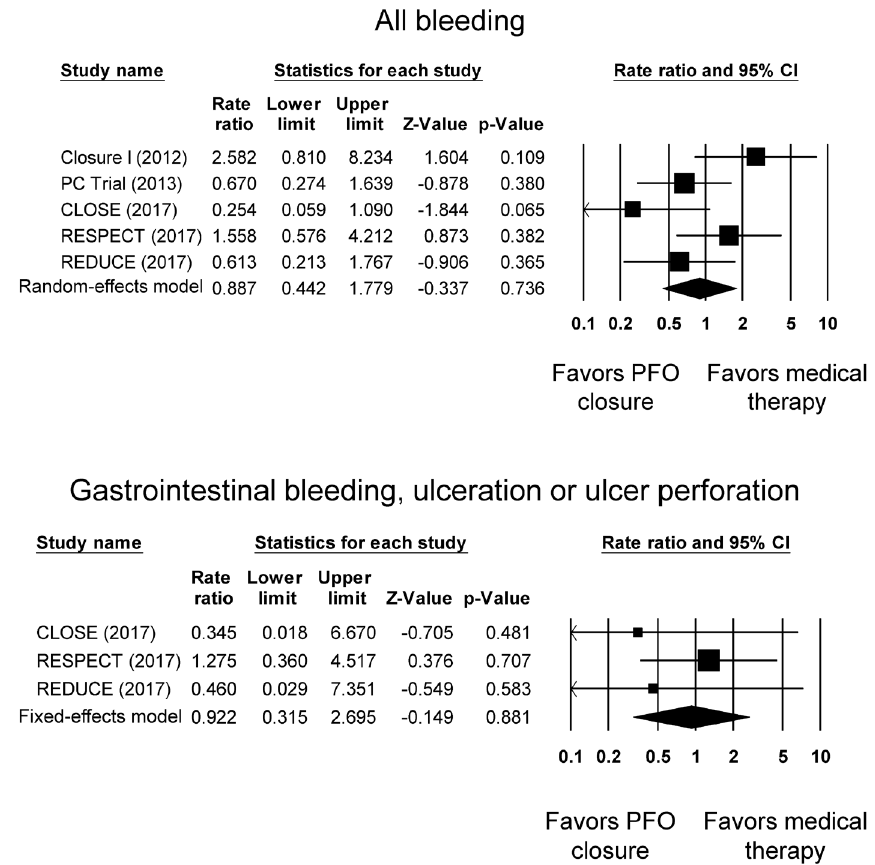
Figure 4. Rate ratios for bleeding (top) and gastrointestinal complications (bottom) in patent foramen ovale (PFO) closure versus medical therapy.